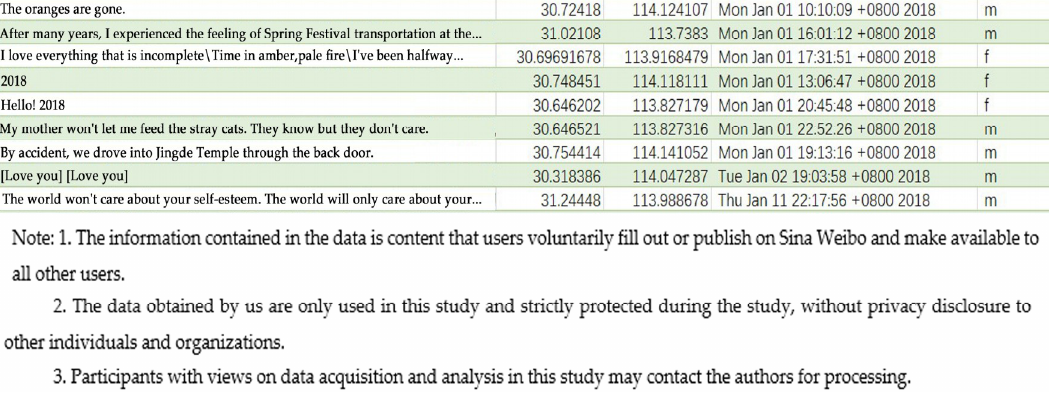
Figure 2. Part of the original data display.